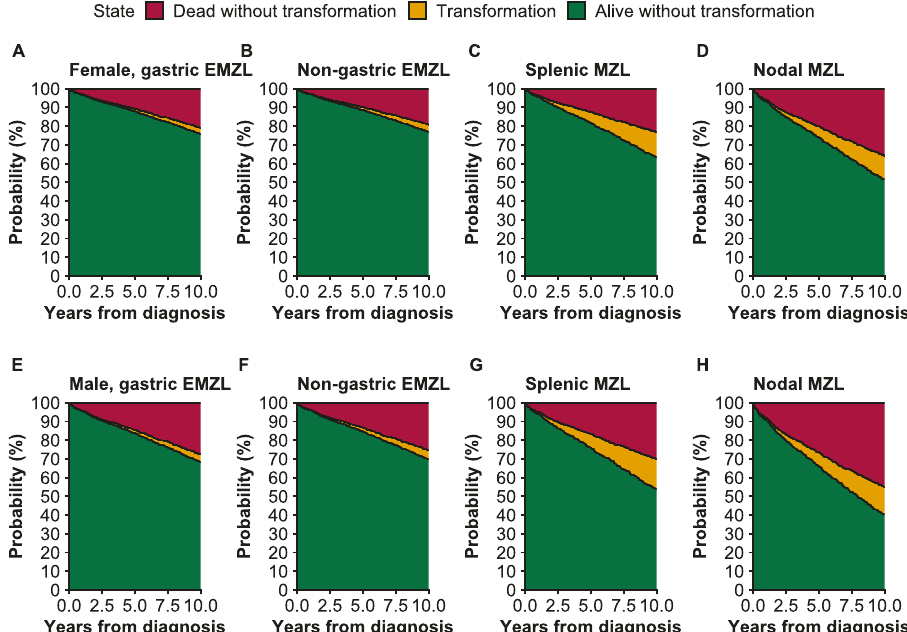
Fig. 2 Stacked cumulative incidence curves for patients diagnosed with marginal zone lymphoma (MZL) at age 65 years in Finland in 2008. A Female, gastric extranodal marginal zone lymphoma (EMZL); B female, non-gastric EMZL; C female, splenic MZL; D female, nodal MZL; E male, gastric EMZL; F male, non-gastric EMZL; G male, splenic MZL; H male, nodal MZL.